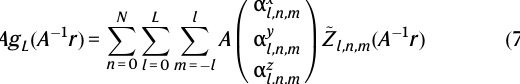
resulting in wrong estimations of the conformational landscape. An example of the undesired effect generated by not considering the missing information along the projection direction is provided in Supplementary Fig. 3.